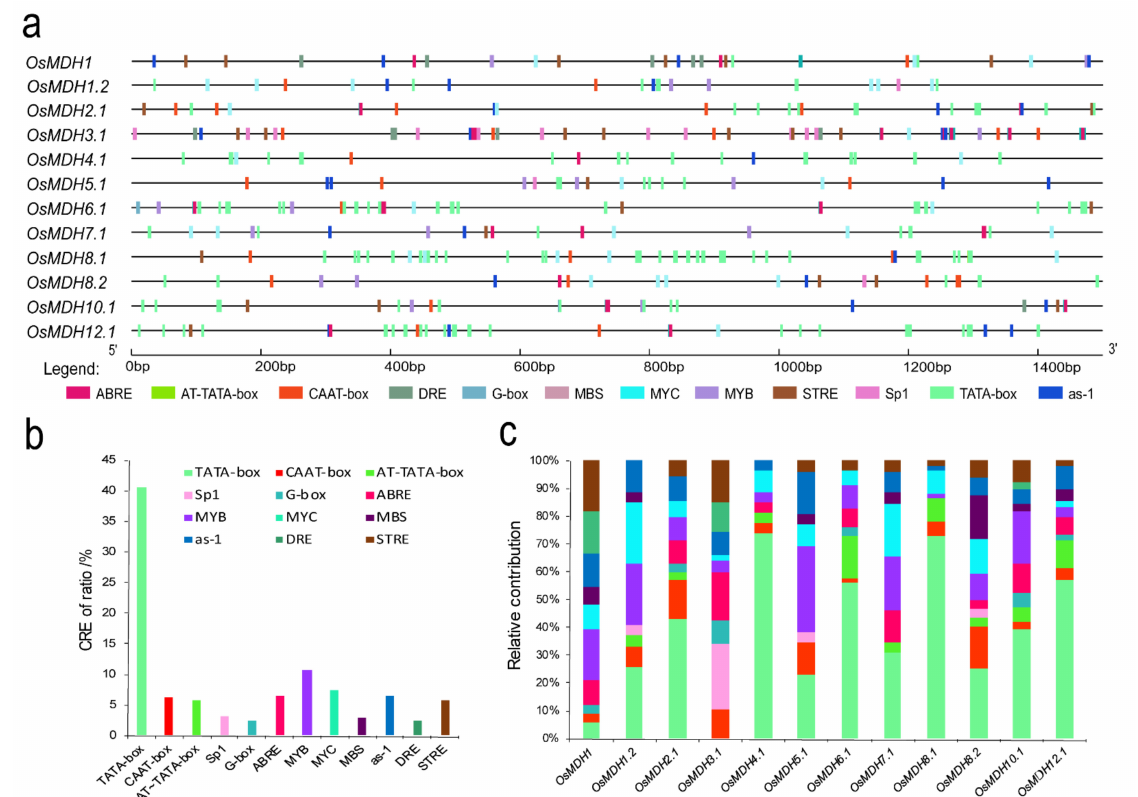
Figure 3. Putative regulatory cis -elements of OsMDH gene promoters. ( a ) The relative positions of cis-regulatory elements are shown on the line representing the 1500 bp upstream region of each OsMDH gene promoter. Only cis -elements required for MBS, G-box, DRE, Sp1, AT-TATA-box, STRE, CAAT-BOX, ABRE, as-1, MYC, MYB, and TATA-BOX are shown. ( b ) Percentage distribution of cis -regulatory elements in the promoters of OsMDH genes. ( c ) The distribution of various elements in the promoter regions of OsMDH genes are shown by different